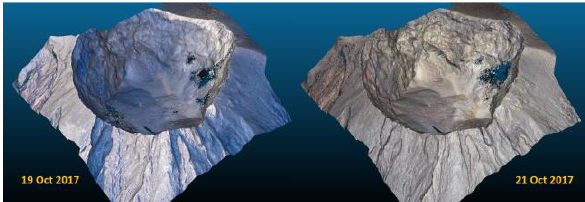
Figure 9. 3D mesh lava dome surface